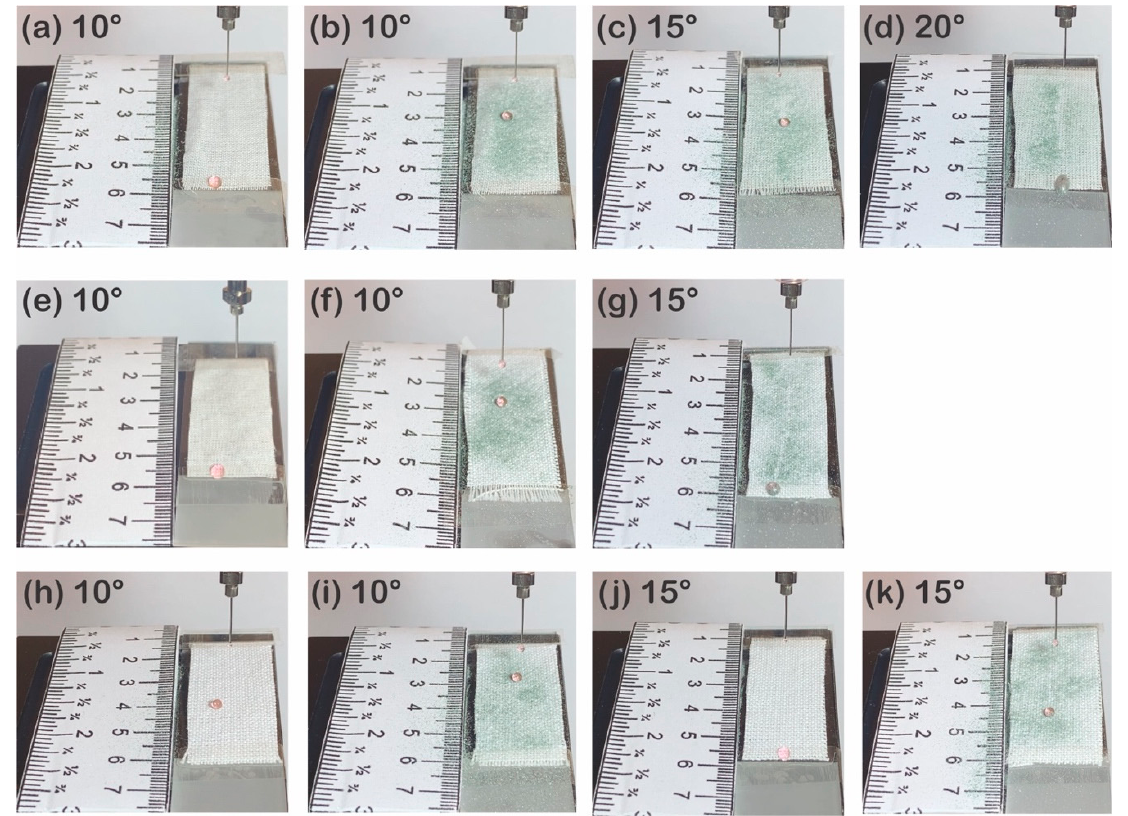
Figure 13. Self-cleaning test of P1T4 PDMS-coated 177D without silicon carbides at 10° ( a ) and with silicone carbides at 10° ( b ), 15° ( c ) and 20° ( d ), P1T4 PDMS-coated 314D without silicon carbides at 10° ( e ) and with silicon carbides at 10° ( f ), 15° ( g ) and P1T4 PDMS-coated 475D without silicon carbides at 10° ( h ) and 15° ( j ) and with silicone carbides at 10° ( i ) and 15° ( k ).